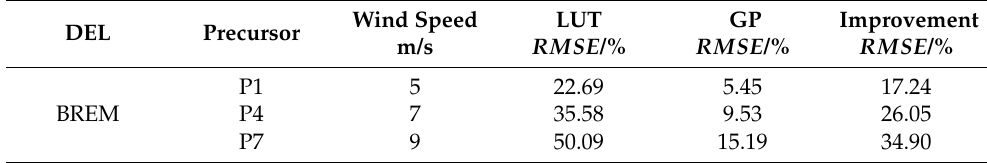
Table 3. RMSE error of blade root edgewise moment.